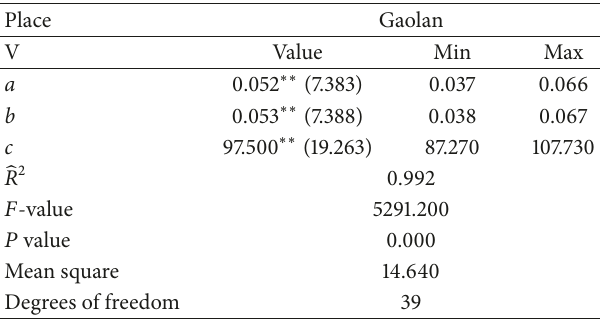
Table 9: Fitting parameters of empirical model on H-5 by laser diffraction